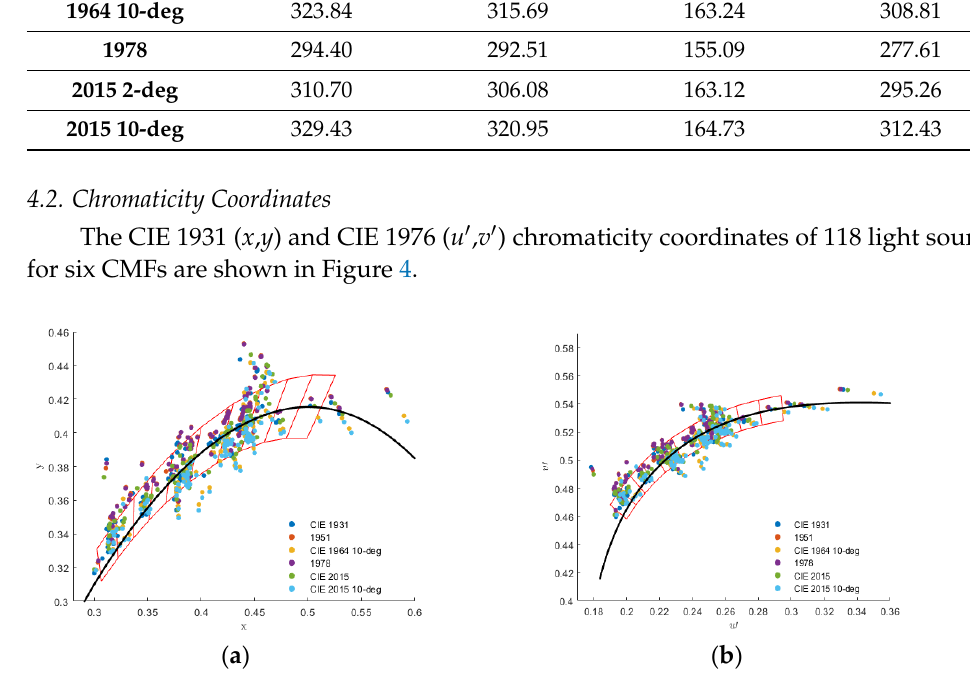
Figure 4. The chromaticity coordinates of 118 light sources using six different color matching functions: ( a ) CIE 1931 ( x , y ); ( b ) CIE 1976 ( u ′ , v ′ ). The black continuous line is the Planckian locus, and the red straight lines show the ANSI 7-step quadrangles [26].